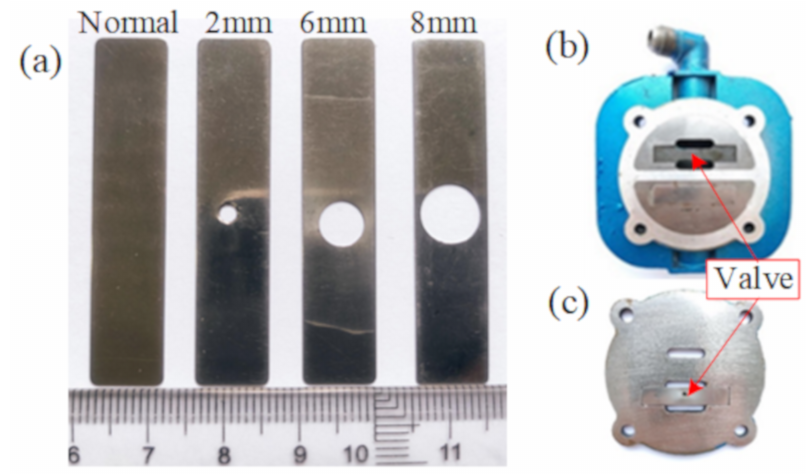
Figure 7. Simulated leakage fault valve; ( a ) valves, ( b ) Upper valve body, and ( c ) Lower valve body.